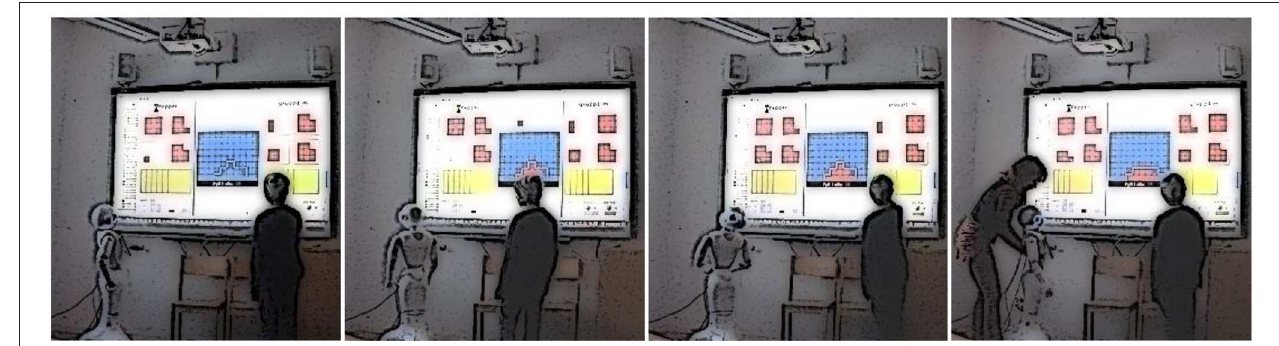
FIGURE 2 | Still images from an interaction session illustrating the experimenter intervening when the robot has turned its back to the child.